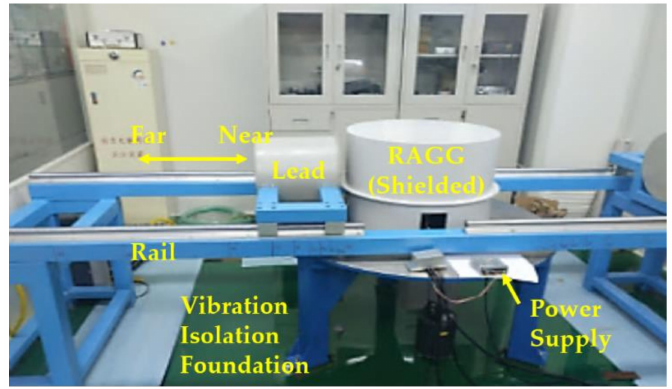
Figure 5. Experiment setup for RAGG’s scale factor